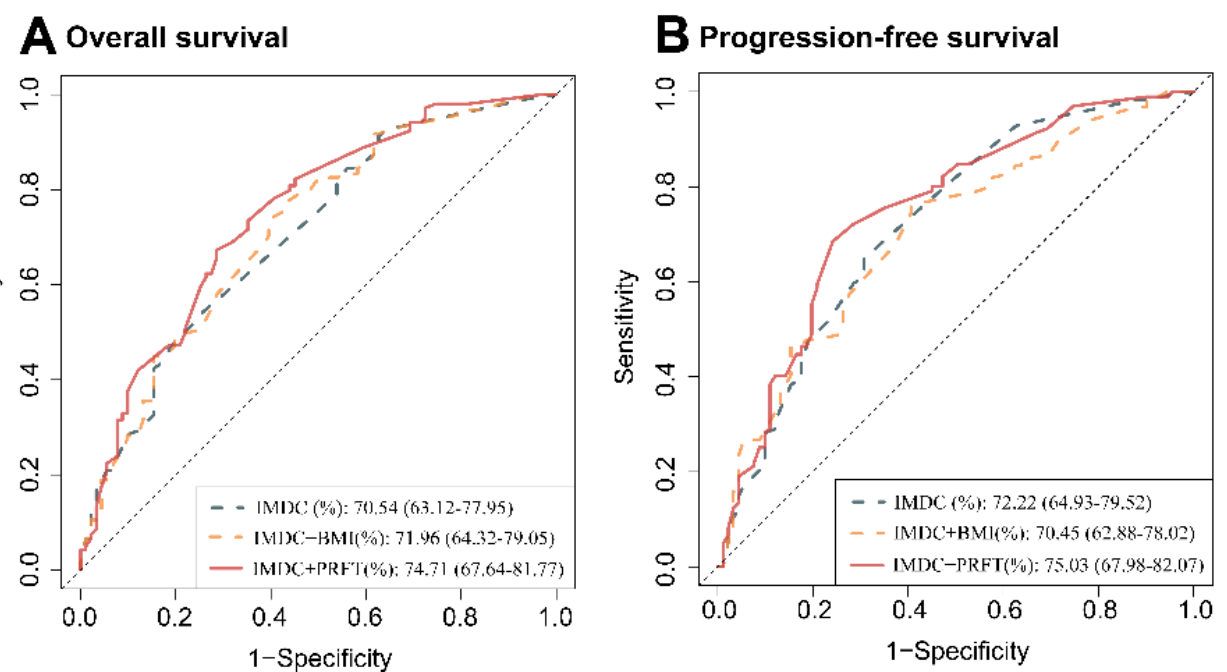
Figure 2. The ROC analysis of OS and PFS in 358 patients treated with target therapy. PRFT can improve the AUC of IMDC risk model for predicting of OS ( A ) and PFS ( B ) in patients with metastatic renal cell carcinoma. AUC: area under curve; BMI: body mass index; IMDC: International Metastatic Renal Cell Carcinoma Database Consortium. PRFT: perirenal fat thickness; OS: overall survival; PFS: progression-free survival; ROC: receiver operating characteristic curve.